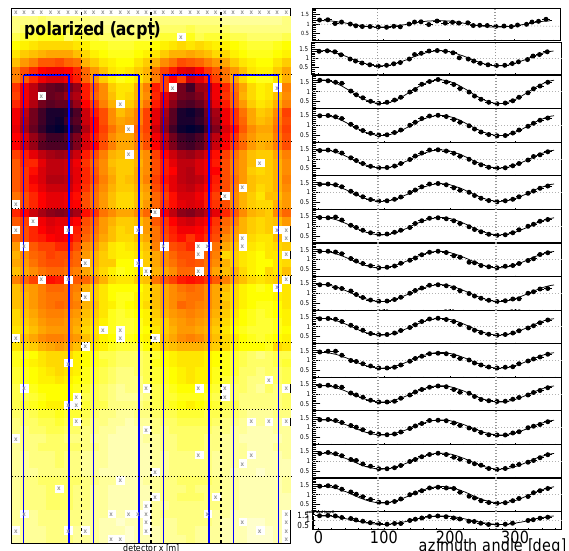
Figure 3: X-Calibur measurement of a polarized beam (energy cut: 36 − 40 keV). Left: 2D map (pixel-by- pixel) of counts. The (blue) boxes indicate the outline of the scintillator. Right: Azimuthal scattering distri- bution (corrected for azimuthal acceptance) for differ- ent rings. The data are fitted by a sine function. The vertical lines indicate the plane of the E field vector of the polarized